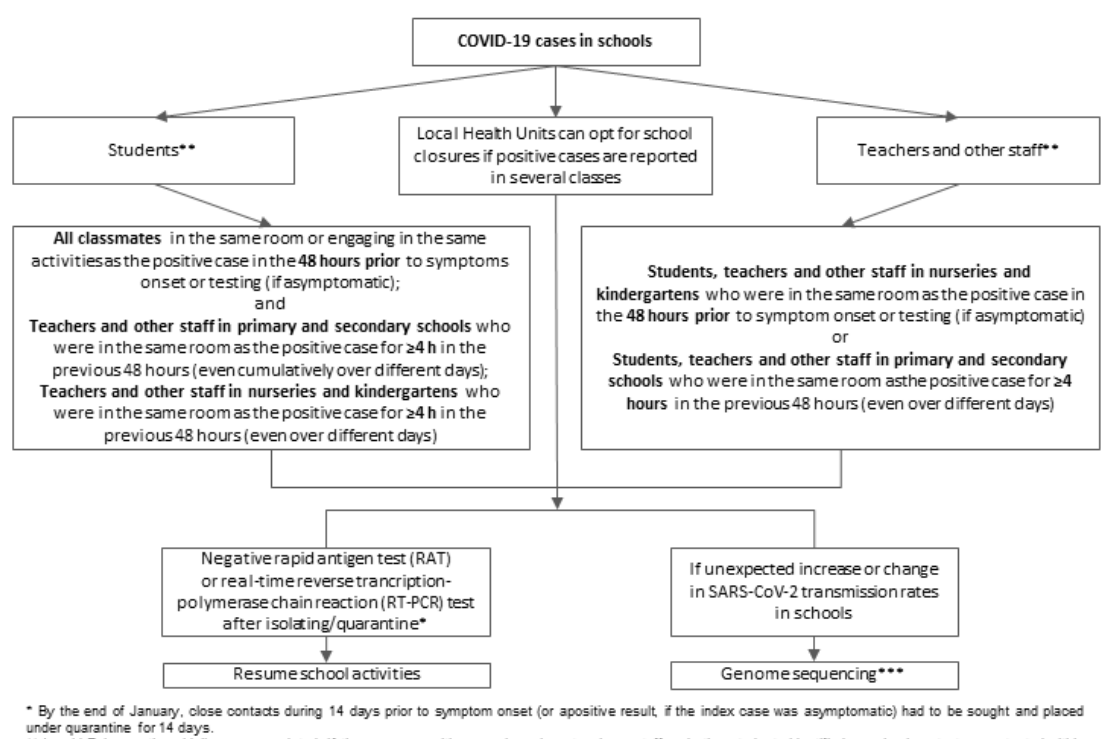
Figure 1. Guidelines for identifying close contacts at school.